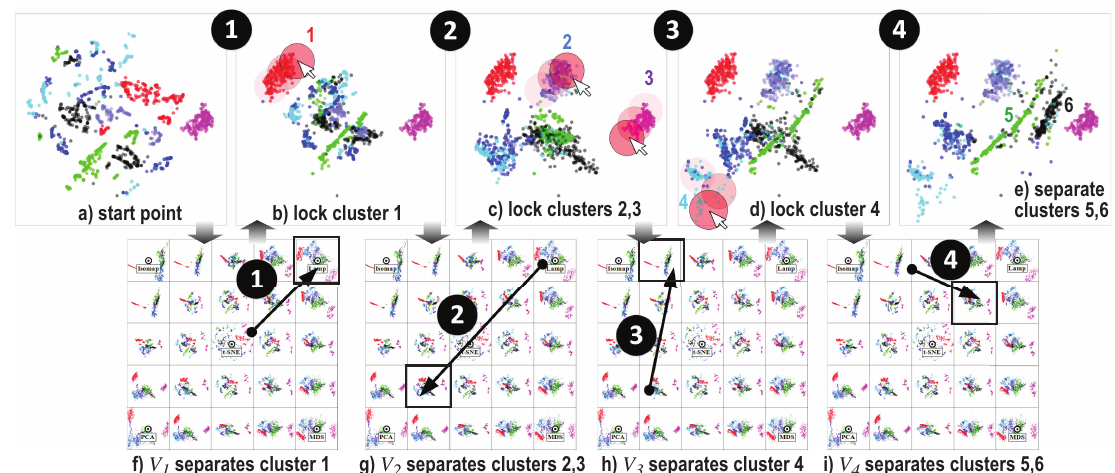
Figure 7. Creating a mixed view which separates well the six classes present in the segmentation